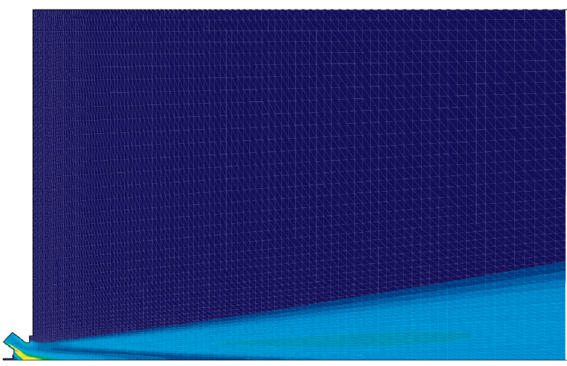
(cid:48) 2 u of the flow with non-swirling atomizing air. Figure 8. '2 Figure 8. of the flow with non-swirling atomizing air. Figure 8. u y of the flow with non-swirling atomizing y